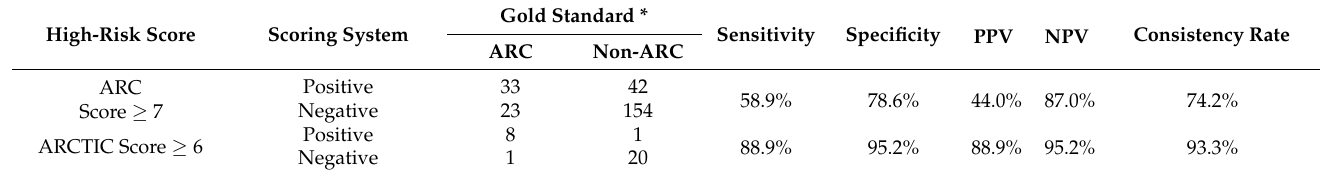
Table 4. Evaluation of the abilities to identify ARC of the ARC risk scoring systems.